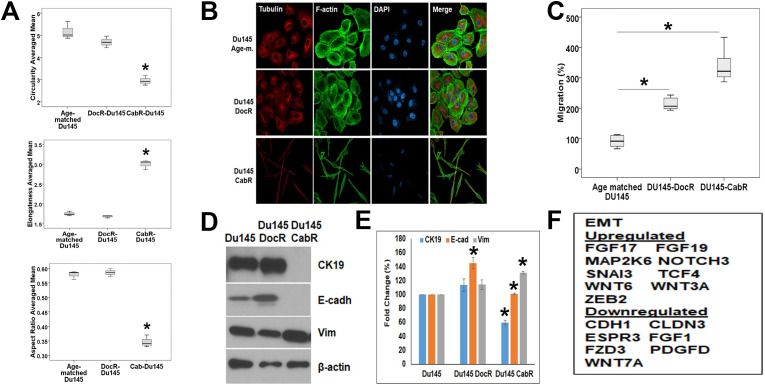
Genotypic and phenotypic characterization of the taxanes resistant Du145 cells (A) Cell morphological study looking at the cell circularity (Top), elongatedness (Middle), and aspect ratio (Bottom). Statistical analyses were performed using the Welch and Brown-Forsythe tests followed by the Games-Howell test, *p < 0.05. (B) Cell morphology analyses showing the distribution of tubulin (Red staining) and F-actin (Green staining) in Du145 age-matched, DocR, and CabR. Nuclei are visualized by DAPI staining (Blue). (C) Migration of the age-matched, DocR and CabR cells using the Inverted Boyden Chamber in vitro assay. Migration of the age-matched cells was used as the 100% migration control. Each cell line was tested in quadruplicate and the experiments were repeated three times. (D) Protein expression level of Epithelial (Cytokeratin 19 and E-cadherin) and Mesenchymal (Vimentin) specific markers. Beta-actin was used as a protein loading control. (E) Protein expression quantification obtained from three separate western blotting experiments. Decreased E-cadherin and CK19, and increased vimentin proteins in CabR cells when compared to the age-matched or DocR cells were all found statistically significant. Statistical analyses were done using a t-test. (F) mRNA expression profile of Epithelial and Mesenchymal specific markers.